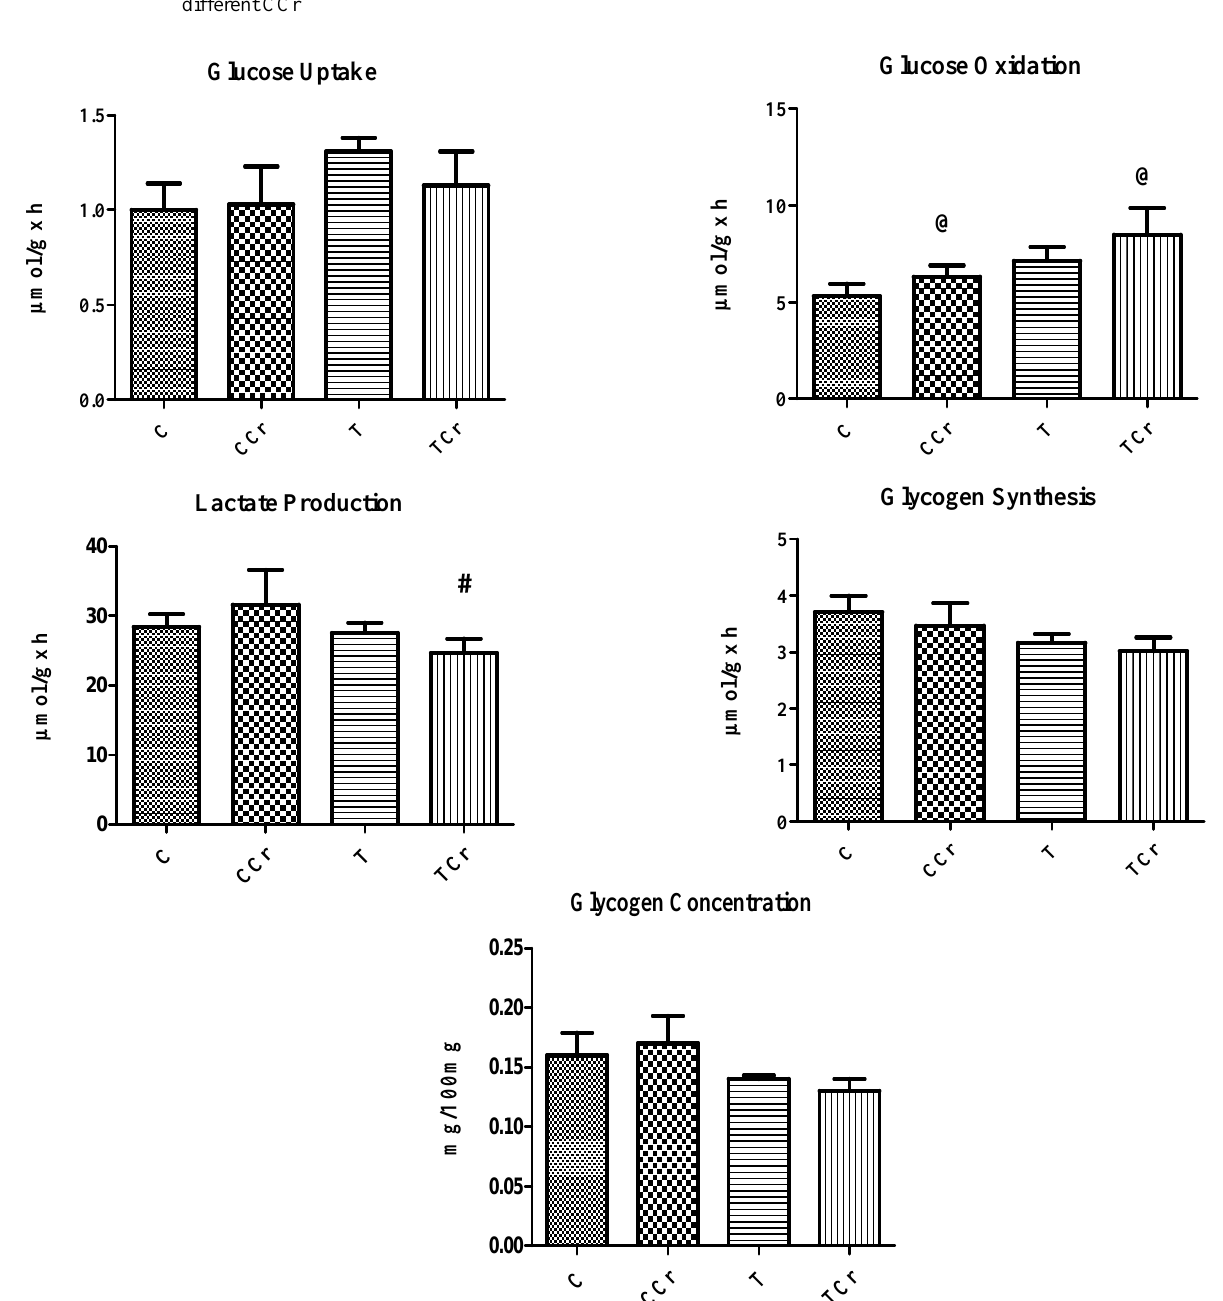
Figure 1. Uptake and glucose oxidation, glycogen synthesis, lactate production and glycogen concentration in isolated soleus muscles after euthanizing the animals. The results are expressed as the mean ± SD of 10 muscle slices per group. CrT = Creatine Trained; T = Trained; CCr = Control Creatine; C = Control not Trained. # different CCr; @ different T and